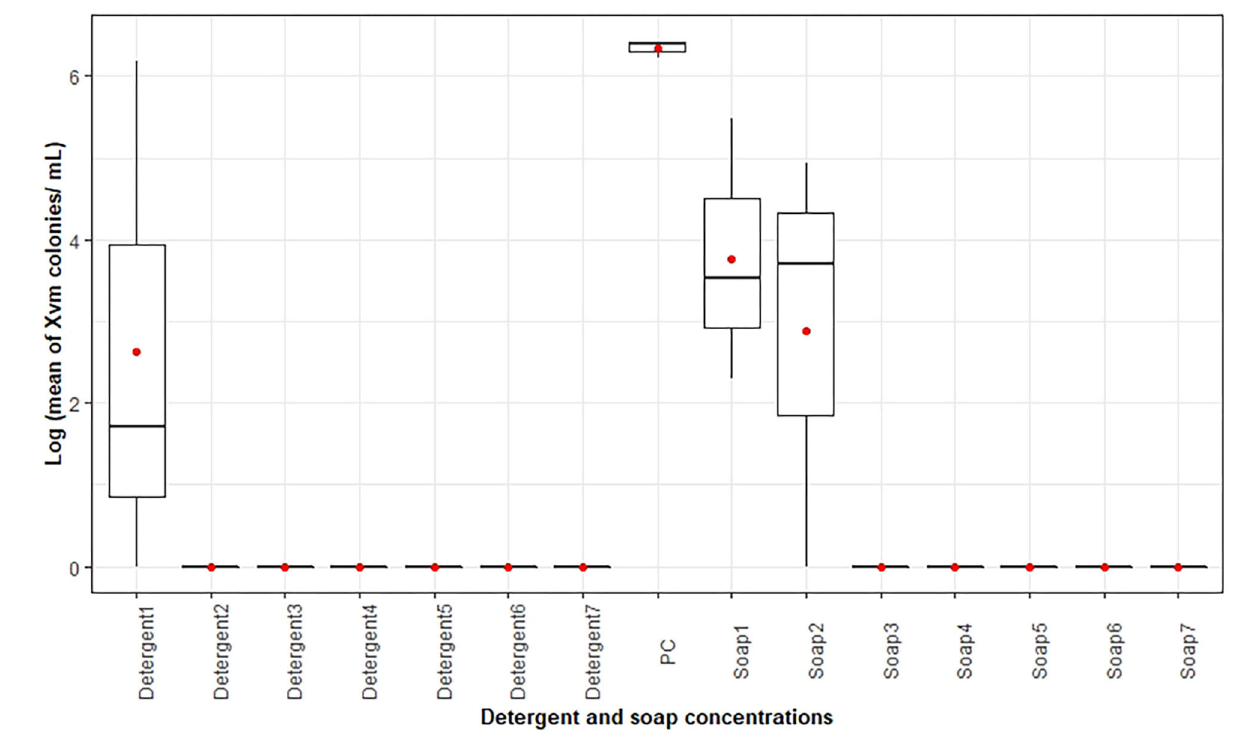
FIGURE 2 | Log 10 of the mean Xanthomonas vasicola pv. musacearum ( Xvm ) colony counts per mL recovered according to detergent and laundry soap concentration. One to seven (on the horizontal axis), respectively, stand for detergent and soap concentrations of 0.00125, 0.0025, 0.005, 0.01, 0.025, 0.03, and 0.035 g/mL. PC denotes the positive control treatment in which Xvm was only suspended in sterile water. The horizontal black lines within the boxes are the median values while the “red circle” is the mean value of the Xvm colony counts. The lower and upper boundaries of the boxes are respectively, the 25th and 75th percentile; the bars/whiskers below and above the box are the 10th and 90th